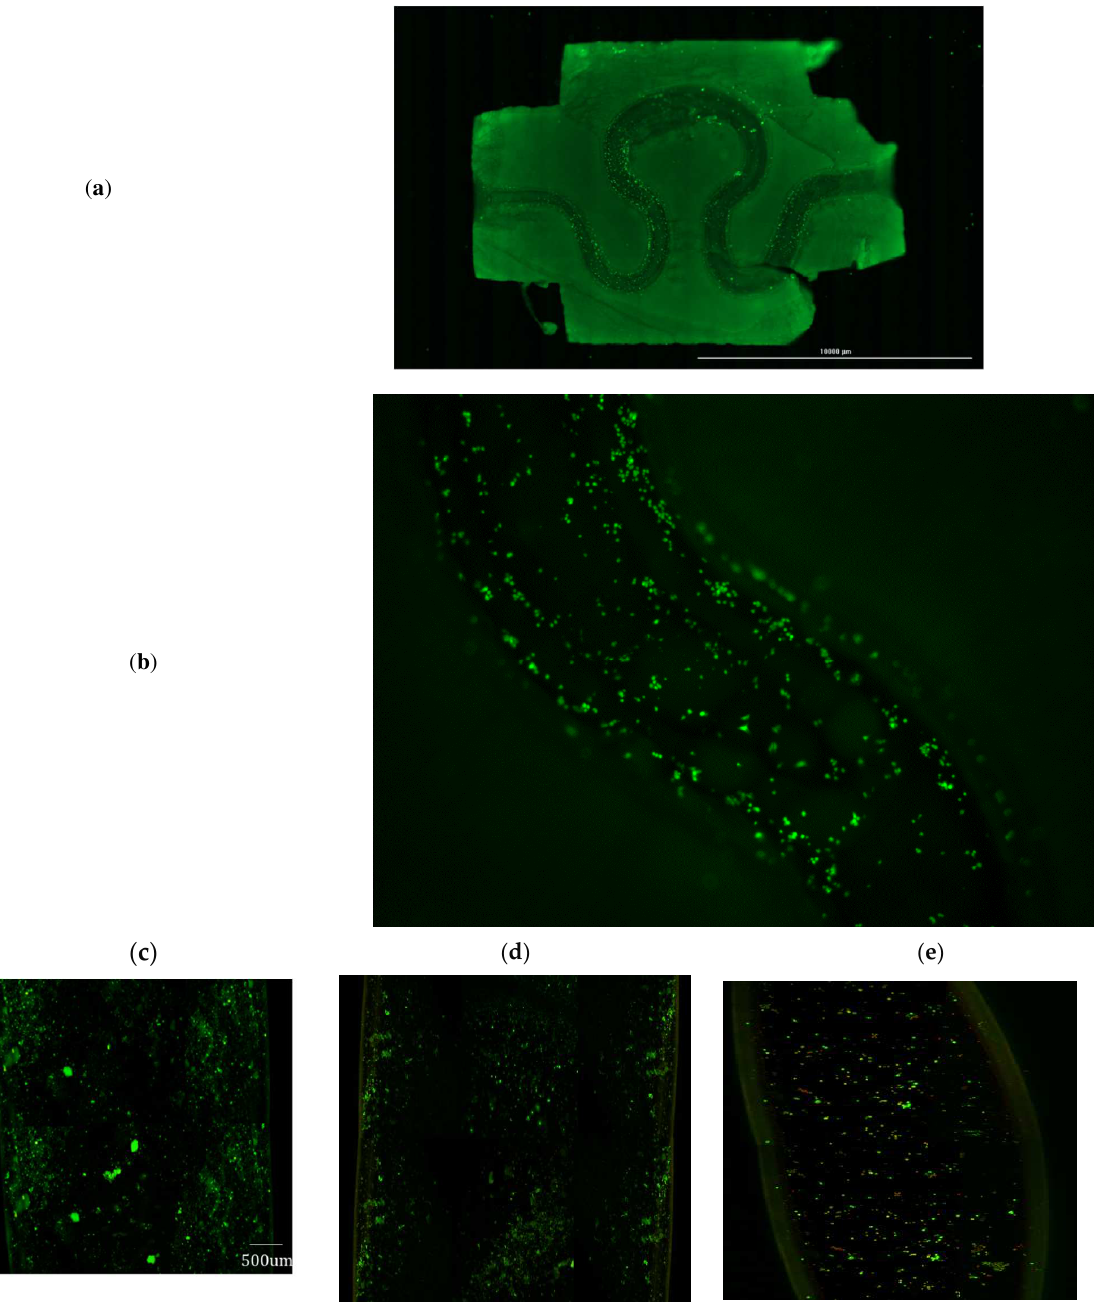
Figure 10. ( a ) Sample bioprinted tissue construct with embedded serpentine channel, ( b ) fluorescent imaging after 14 days, ( c ) confocal imaging after 14 days by staining with LIVE-DEAD assay of serpentine channel seeded with HUVECs at inlet flow velocity = 4.62 mm/min, ( d ) 4.48 mm/min, ( e ) 4.76 mm/min. υ